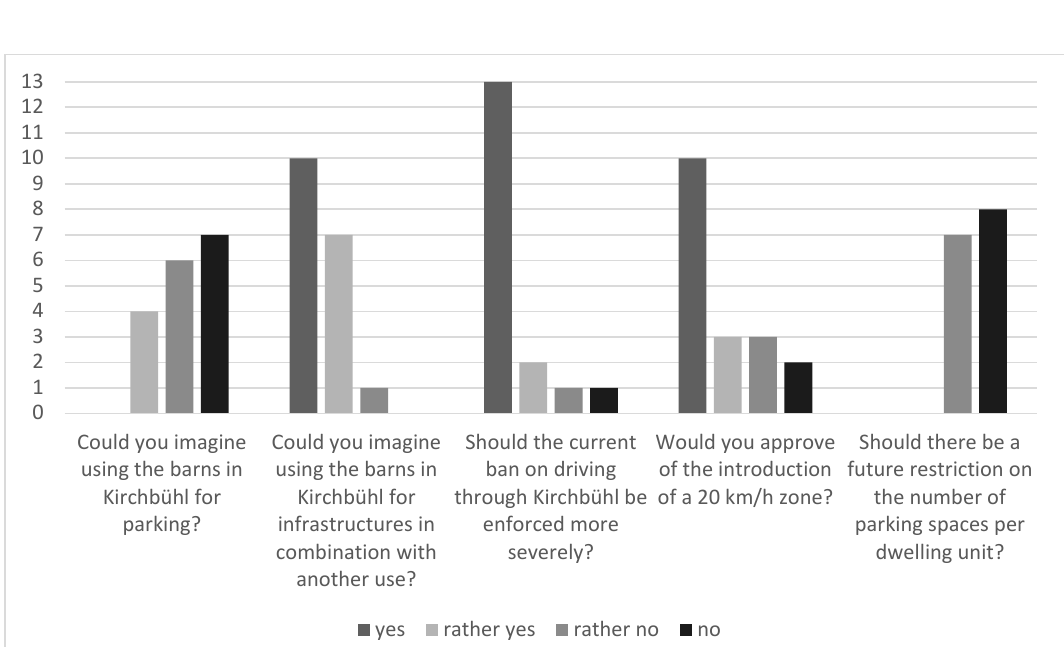
Figure 19: Results of development proposals for the